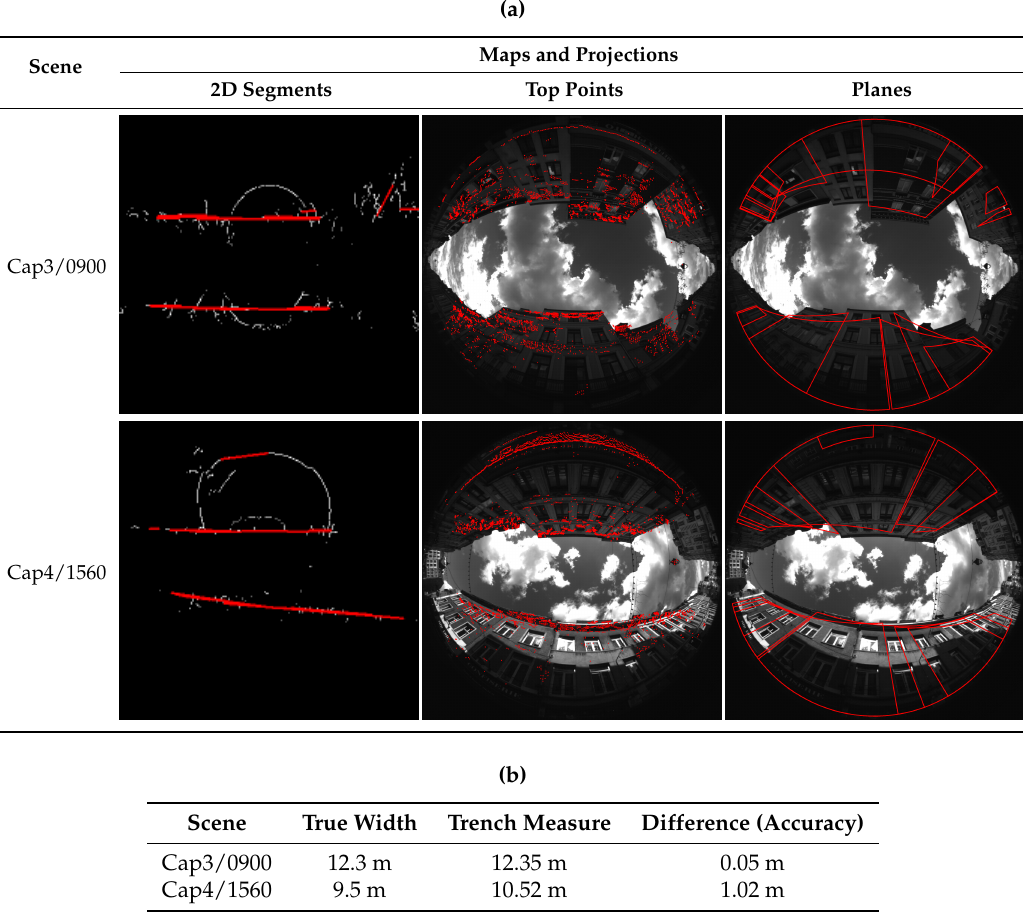
Table 2. Streets width evaluation from detected planes. ( a ) Qualitative evaluation; ( b ) Quantitative